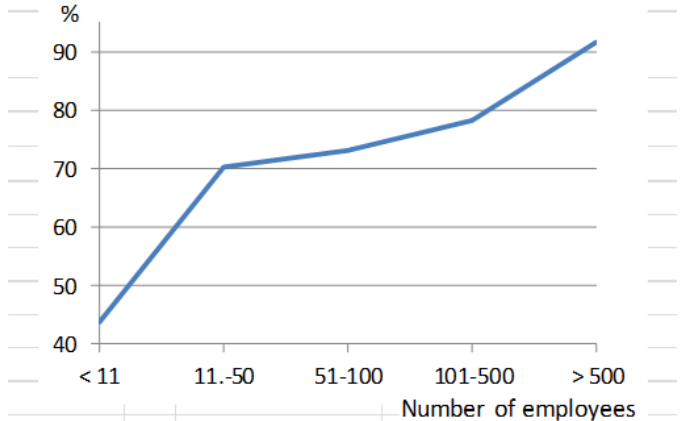
Figure 3. The %EOls average value (on aspects 3 - 26) dependence on the number of employees at 100% i-security